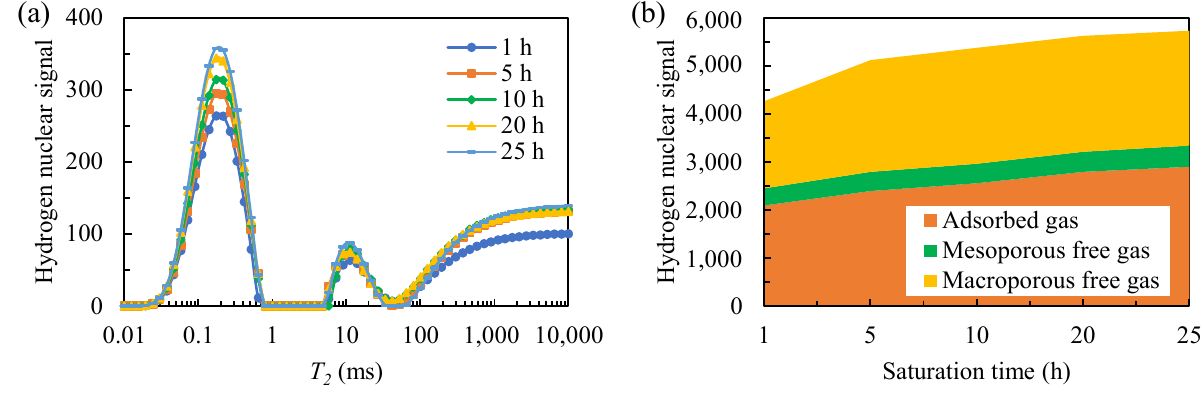
Figure 4. ( a ) T 2 spectra of shale samples and ( b ) signals of different types of methane during methane saturation. The ranges of the adsorbed gas peak, mesopore-free gas peak, and macropore-free gas peak in the T 2 spectrum are (0.01ms < T 2 < 1 ms), (1ms < T 2 < 25 ms), and ( T 2 > 25 ms), respectively. The formation mechanisms of shale gas are in situ retention accumulation and con- tinuous distribution [55]. Adsorbed gas not only exists in micropores but also adsorbs on the walls of mesopores and macropores [56]. Adsorbed gas shows a hydrogen nucleus signal with a low relaxation time on the NMR relaxation map. At the beginning of satura- tion, methane quickly enters the shale, and most of the gas exists as adsorbed gas and